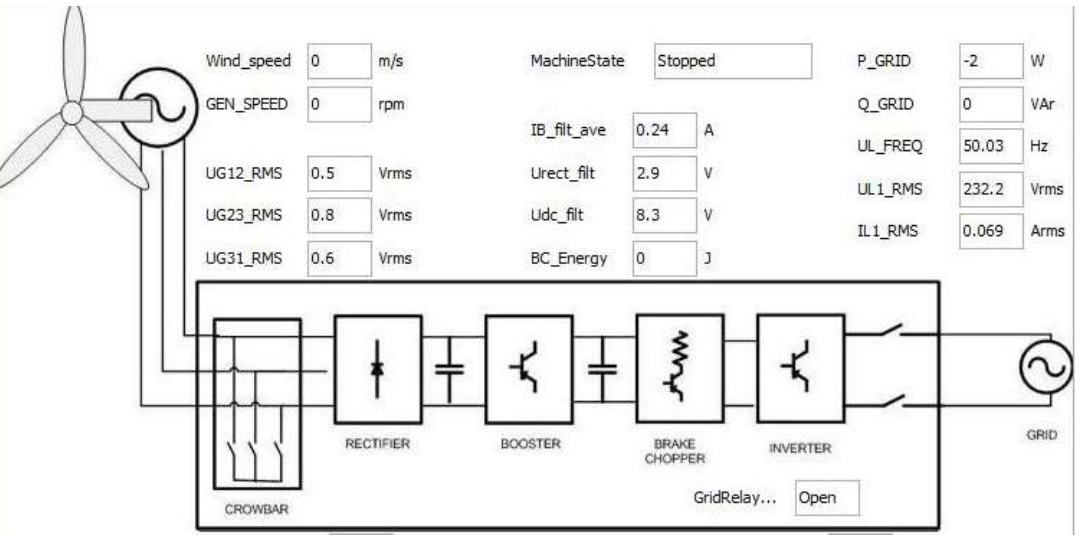
Figure 10. Block diagram of the electronic control system of the WINDERA wind turbine [36].